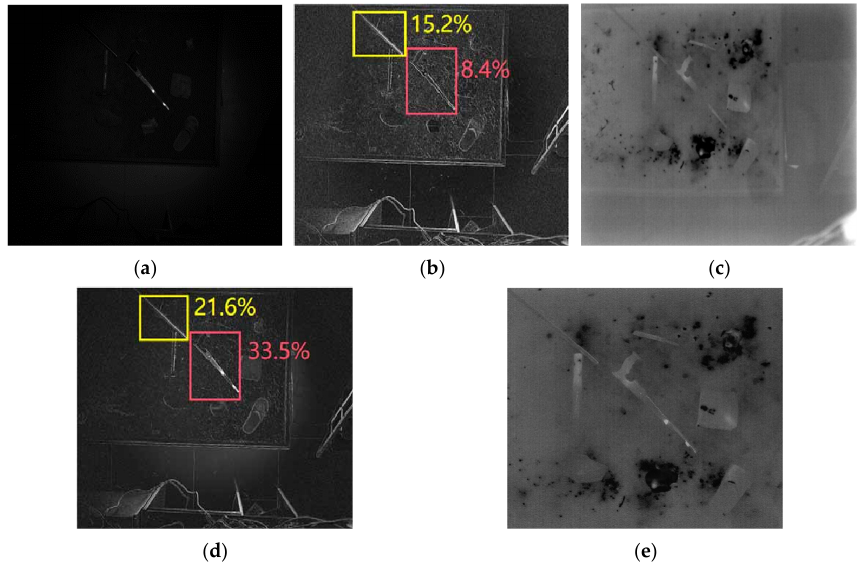
Figure 8. Intensity, polarization, infrared, and fused images under LED light at night. ( a ) intensity image; ( b ) DoLP image; ( c ) Infrared image; ( d ) Intensity Polarization Fusion Image; ( e ) Intensity, polarization, and infrared fusion images.